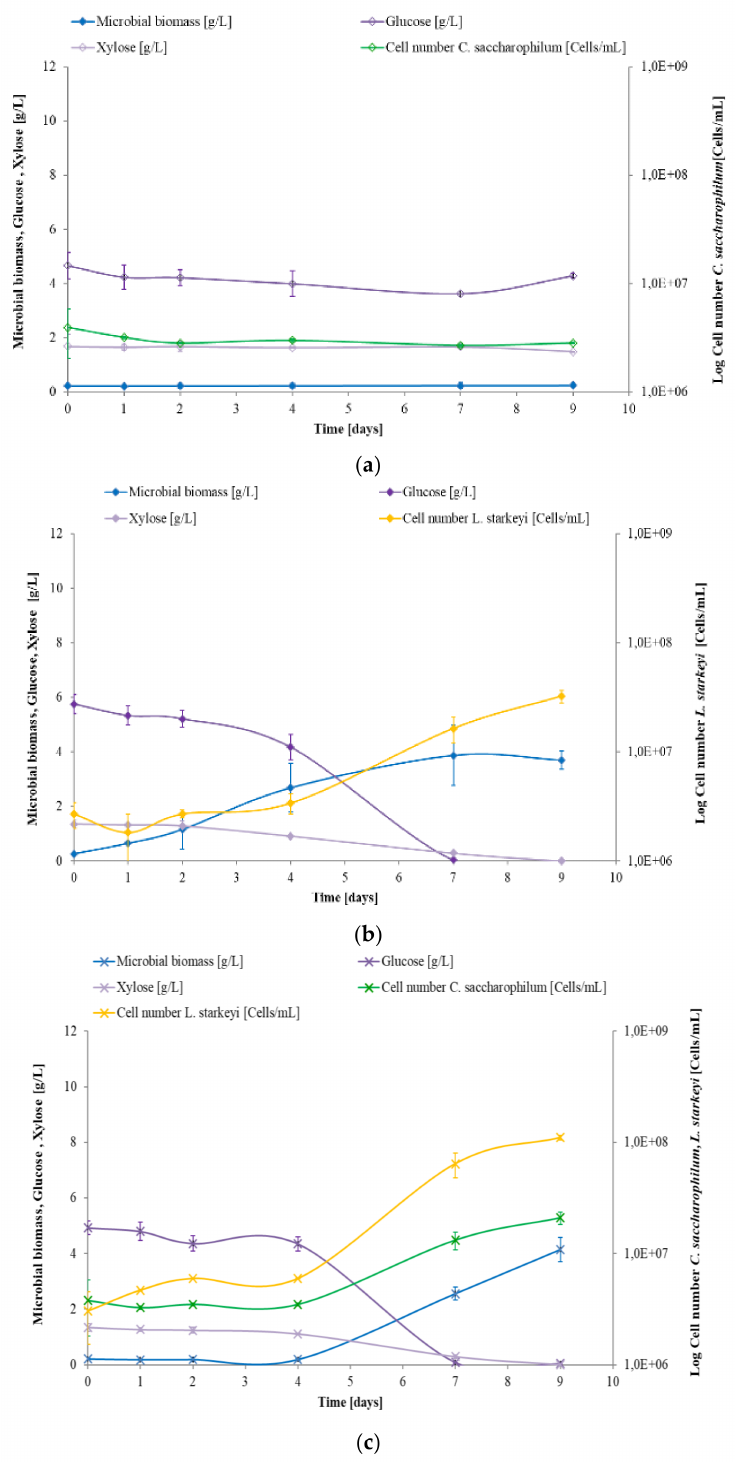
Figure 3. ( a , b ) Profiles of microbial biomass (g/L), glucose consumption (g/L), xylose consumption (g/L) and cell number (cells/mL) in Arundo donax hydrolysate (ADH) inoculated by C. saccha- rophilum ( a ) and L. starkeyi ( b ). ( c ) Profiles of microbial biomass (g/L), glucose consumption (g/L), xylose consumption (g/L) and cell number (cells/mL) in Arundo donax hydrolysate (ADH) inoculated by C. saccharophilum and L. starkeyi in mixed